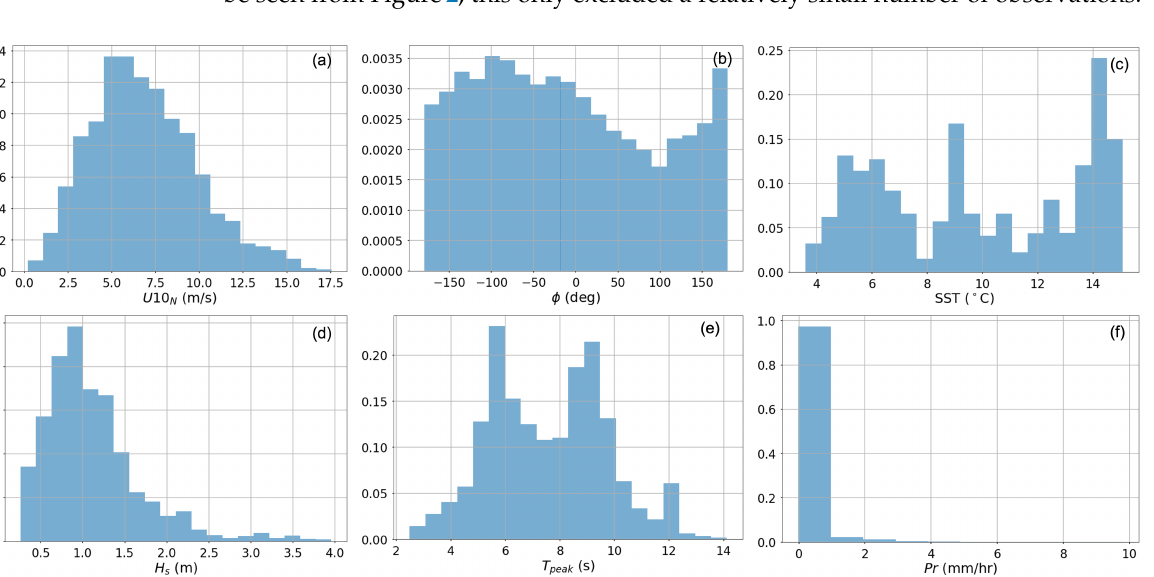
s , ( e ) peak wave period T peak and